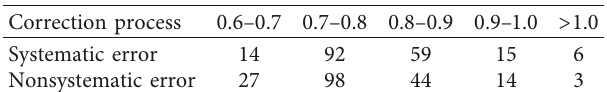
Table 8: Distribution of ratios of RMSE of corrected 24h forecast of temperature on 500hPa to the forecast of GRAPES